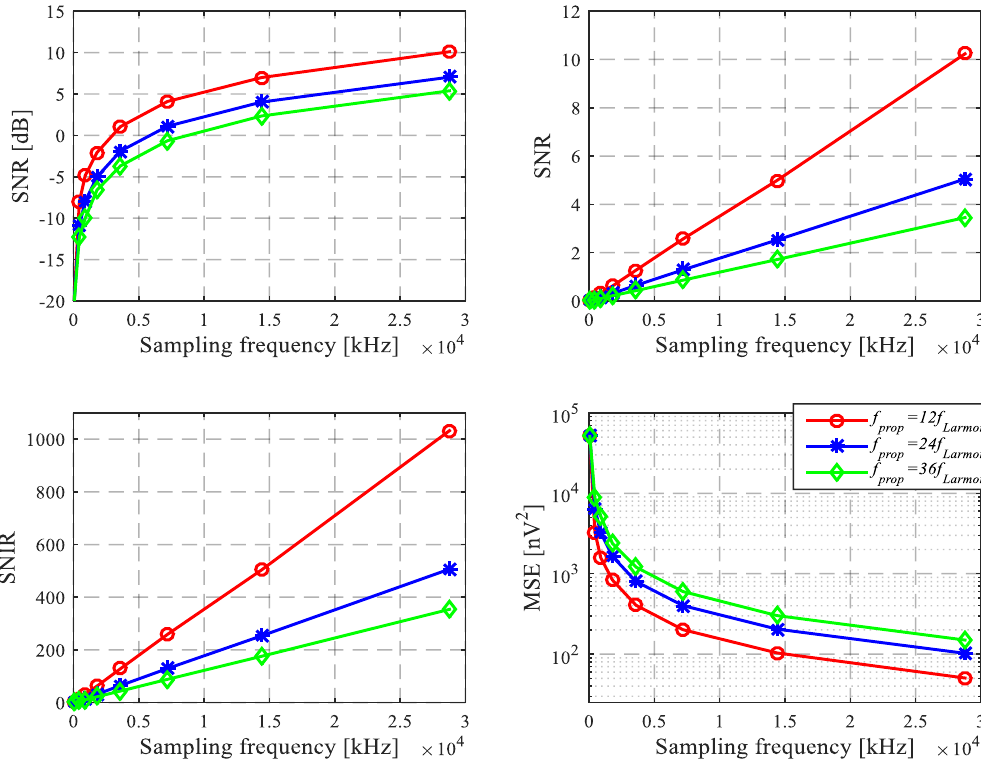
Figure 9. Di ff erent f prop e ff ect on sparse reconstruction. The first row shows the comparison of SNR in f effect on sparse reconstruction. The first row shows the comparison of Figure 9. Different prop di ff erent f prop cases, respectively. The second row shows the comparison of SNIR and MSE in di ff erent f cases, respectively. The second row shows the comparison of SNIR and MSE SNR in different f prop cases, prop f cases, respectively. in different prop